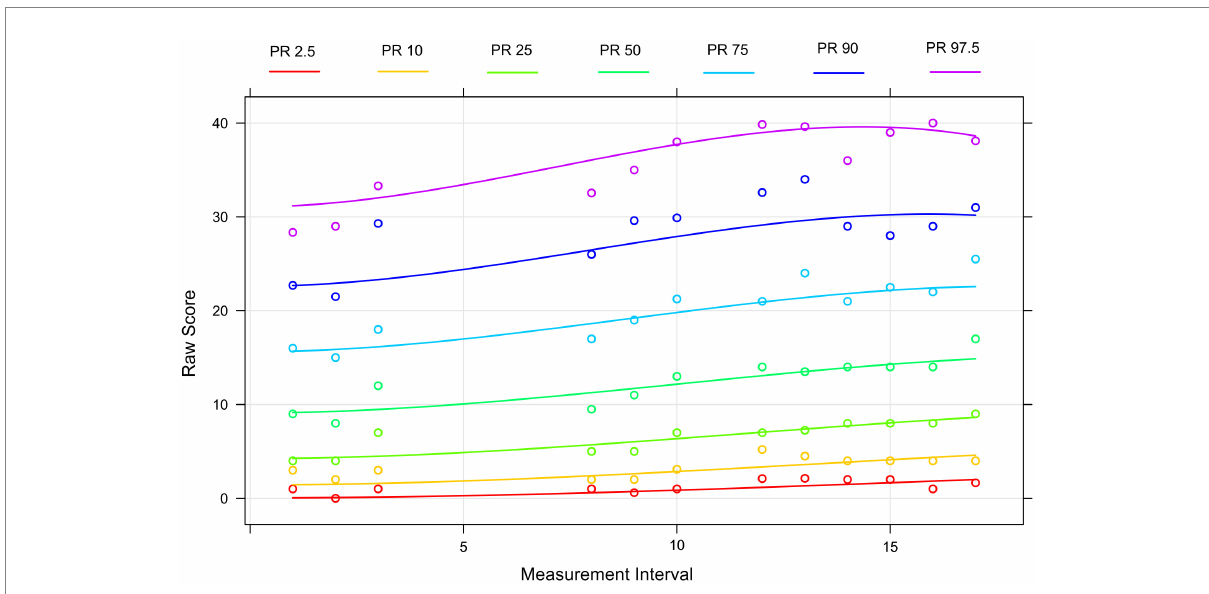
FIGURE 2 Percentile curves based on the sample of the mixed addition and subtraction LPM test. The curves show, which raw score ( y -axis) is assigned to a specific ability level (each represented by a percentile curve) at a certain LPM measurement interval ( x